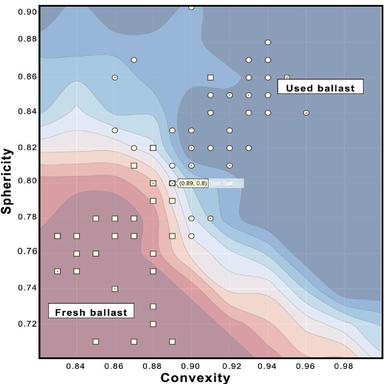
Ballast particle identification results from multiple learning based on KNN.